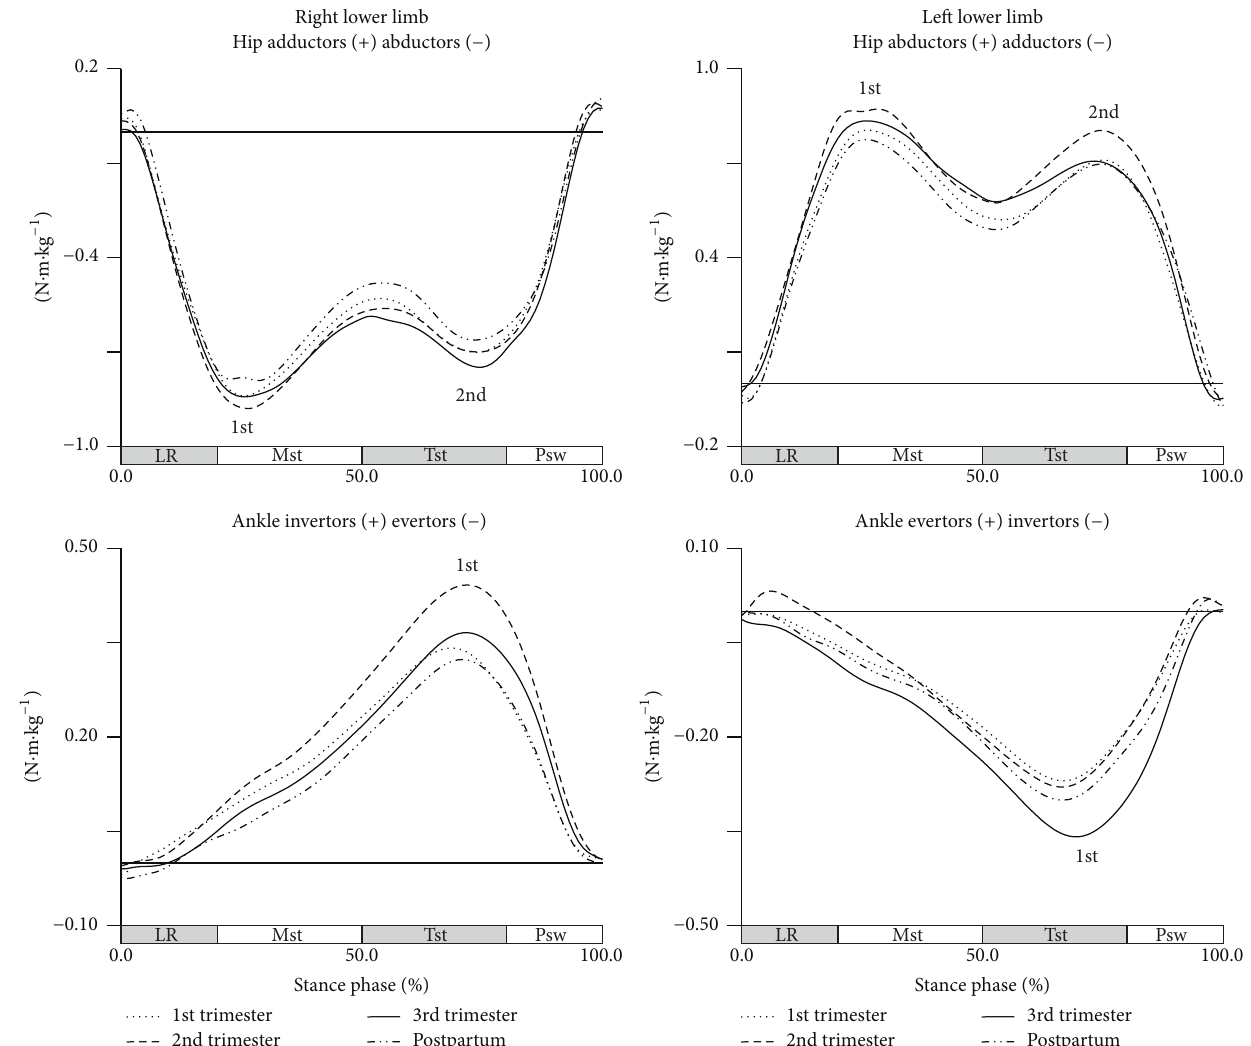
Figure 3: Joints moments in the frontal plane during gait (in N ⋅ m ⋅ kg −1 ). Each line represents the later stages of first (dotted line), second (dashed line), and third trimesters (solid line) and of postpartum period (dash-dot-dot line). Mean joint moments of the hip and ankle, for right and left lower limbs. The curve peaks are indicated by numbers: 1st and 2nd, and ( ∗ ) points the significant